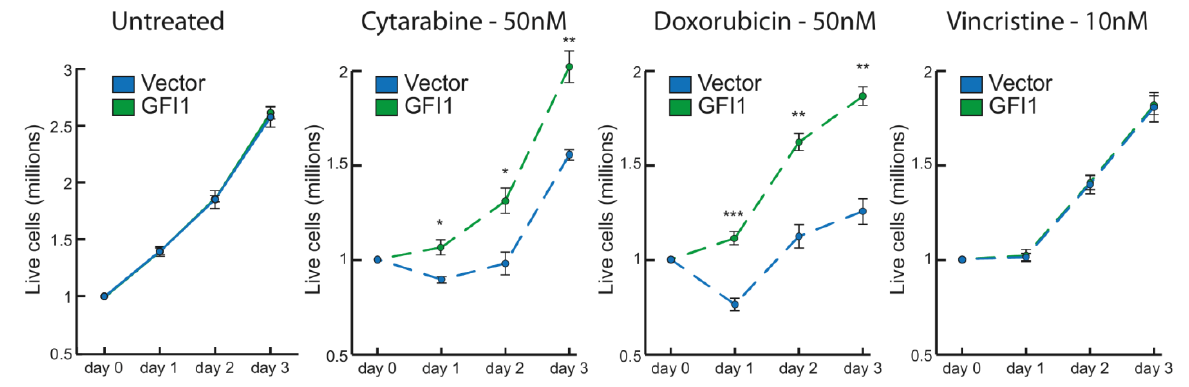
FIGURE 2: GFI1 overexpression protects from DNA damage based drug treatments. GFI1 overexpressing SupT1 cells and vector control cells were seeded at 1 million cells per ml and exposed to the indicated drugs. Cells were counted each following day. Average cell num- bers are shown. * = p <0.05, ** = p<0,01, *** = p<0,001 on a Welch corrected T